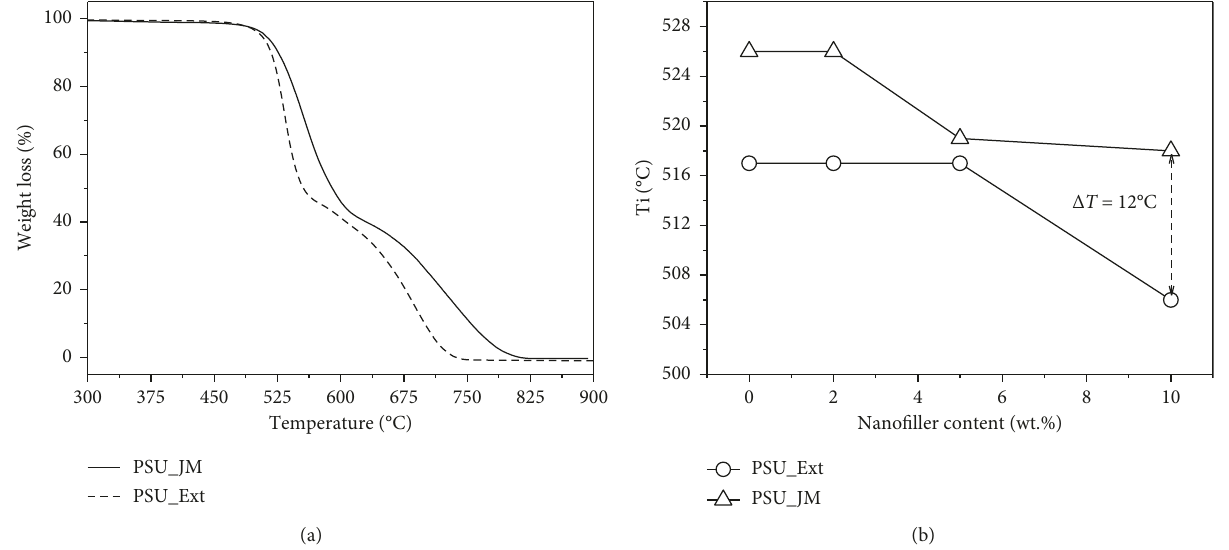
i ) versus nanofiller